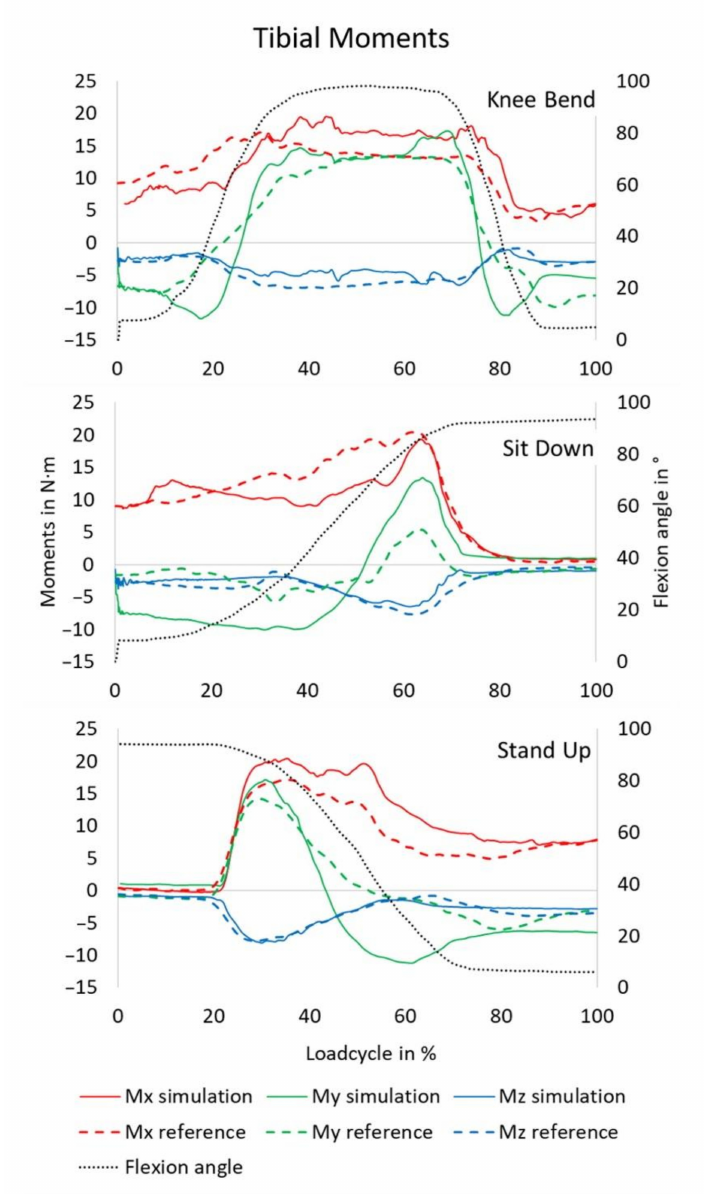
Figure 5. Comparison of simulation output to the reference data for the tibial moments for knee bend, sit down, and stand up